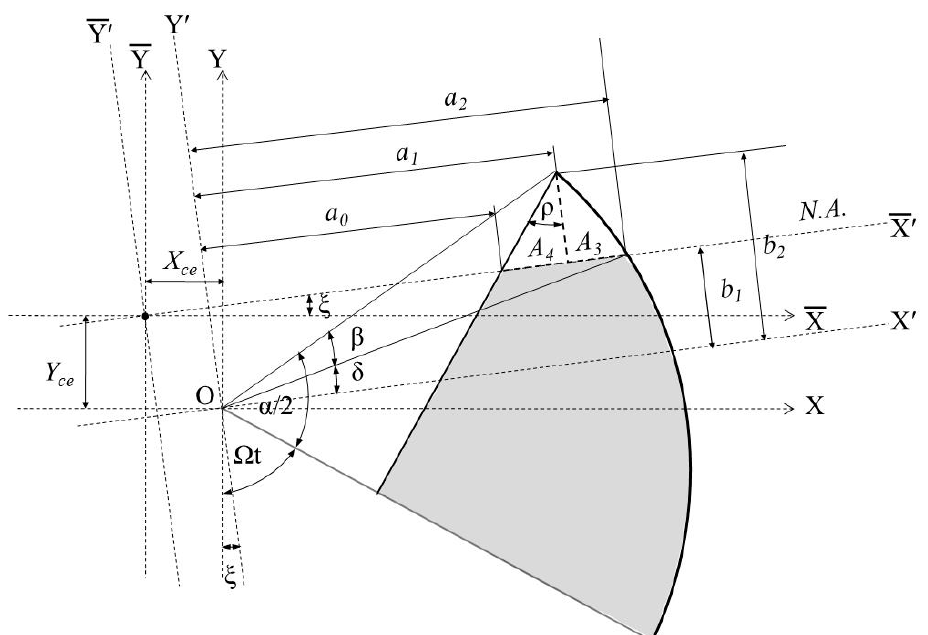
Figure A3. Geometry of a partially open crack and relevant coordinate axis systems.